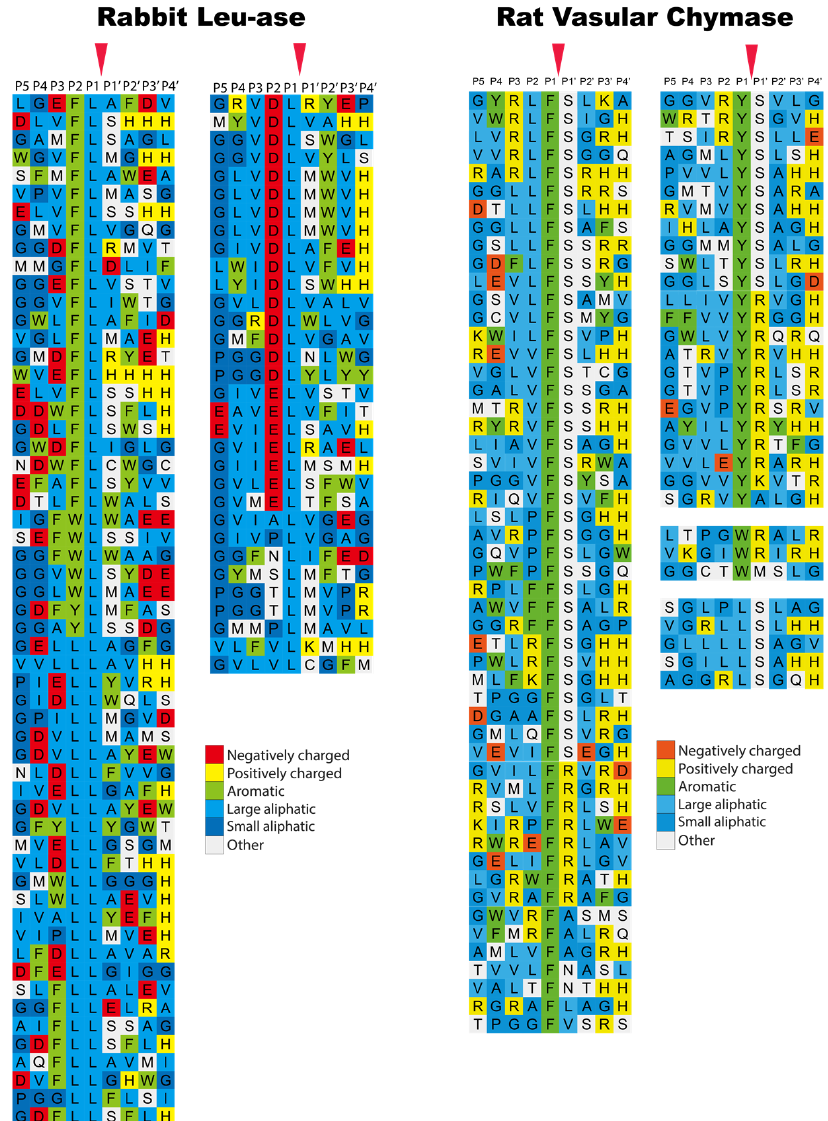
Figure 7. Phage display results for the rabbit β -chymase, a Leu-ase, and the rat vascular chymase (RVC). The amino acids in the phage display results are color coded as shown in the bottom of the figure. The cleavage by the enzyme occur after the P1 residue as marked by red arrow heads. The figure contains data from two earlier publications [48,49].